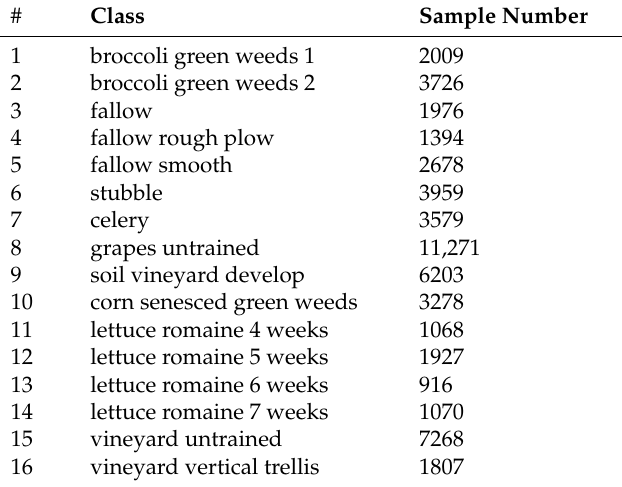
Table 1. Summary of ground truth in Figure